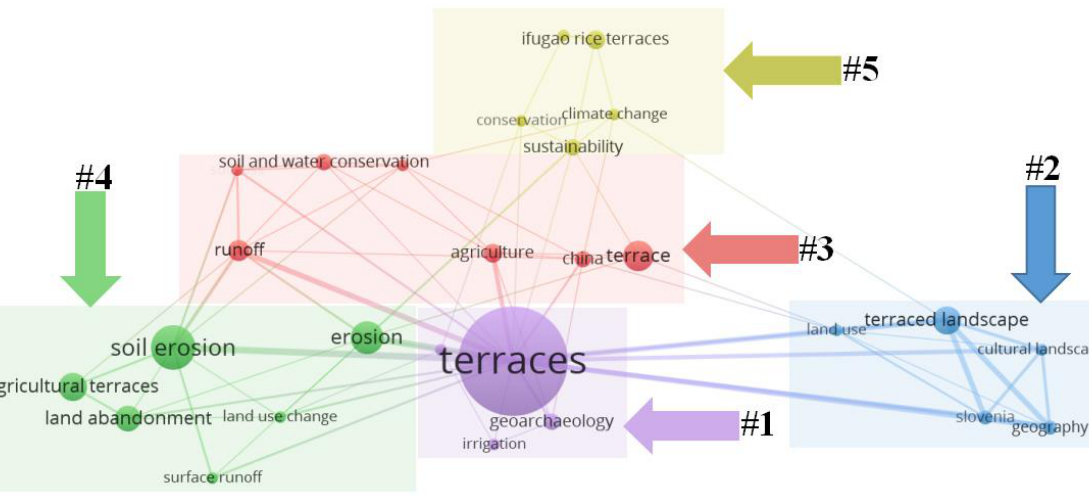
Figure 7. Co-occurrence network of agricultural terrace keywords.